Question: According to this chart, does the measure grow or shrink?
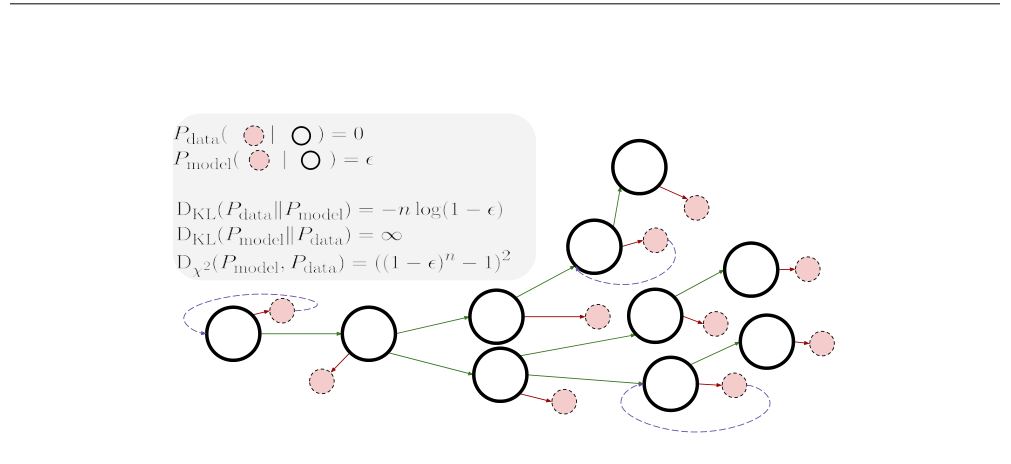
Answer: increasing